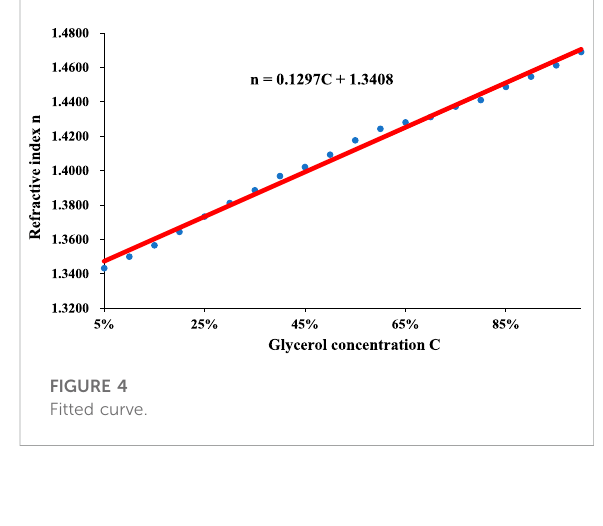
FIGURE 4 Fitted curve.